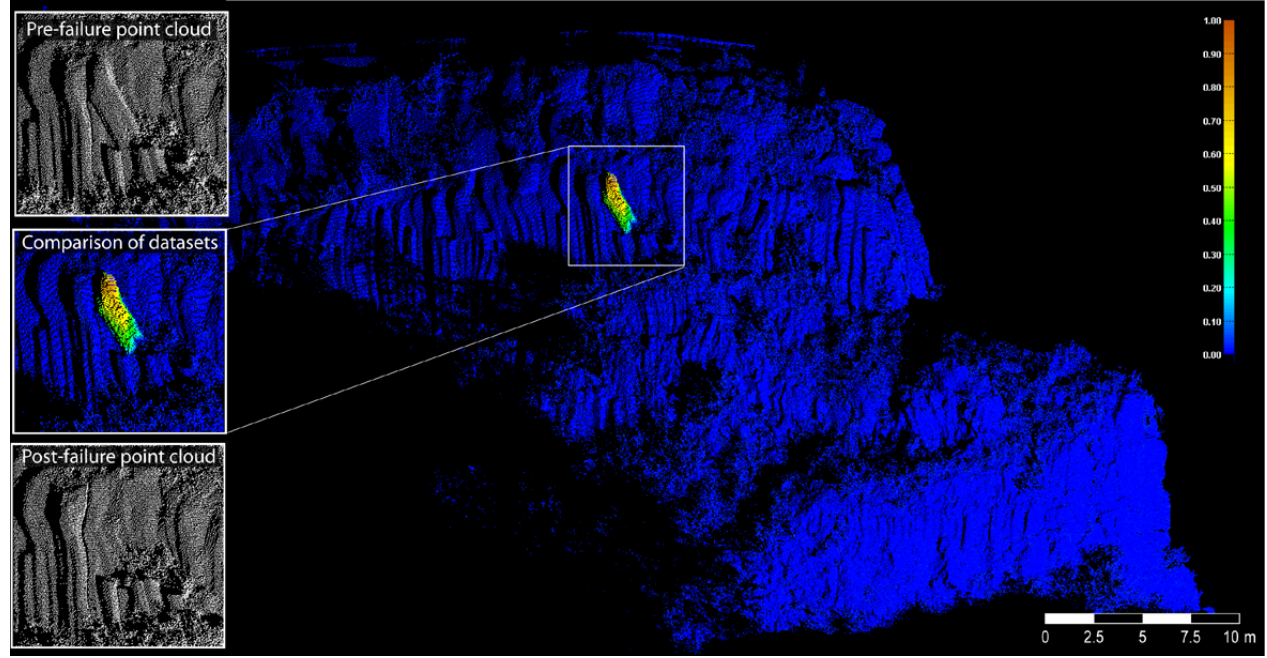
Fig. 5. Comparison of the sequential TLS datasets. Each point of the 3-D point cloud is colour-coded in accordance with the changes recorded during the period of comparison (September vs. December 2006). The failure of a single basaltic column and small changes in vegetation are visible. Pre and post failure stages are visible on the